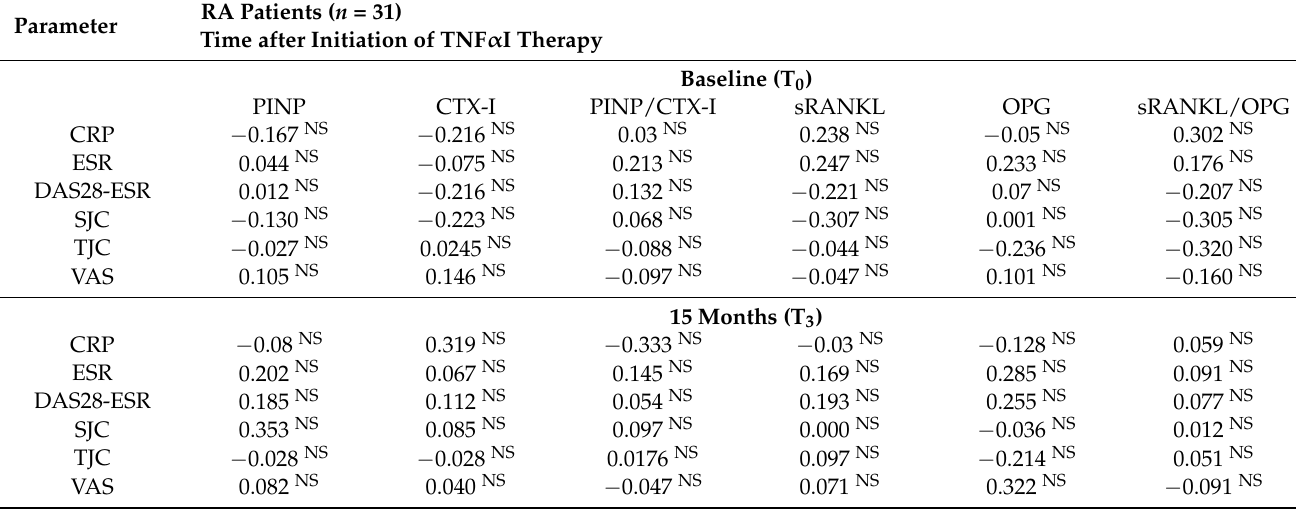
Results are expressed as r (correlation coefficient) according to Spearman rank correlation. Correlations were considered significant at: p < 0.0083 by applying a Bonferroni correction. DAS 28-ESR, disease activity score 28; CTX-I, C-terminal cross-linking telopeptides of type I collagen; ESR, erythrocyte sedimentation rate; NS , not significant; OPG, osteoprotegerin; PINP, N-terminal propeptides of type I procollagen; RA, rheumatoid arthritis; SJC, swollen joint count; sRANKL, total soluble receptor activator of nuclear factor κ B ligand; TJC, tender joint count; TNF α I, tumor necrosis factor α